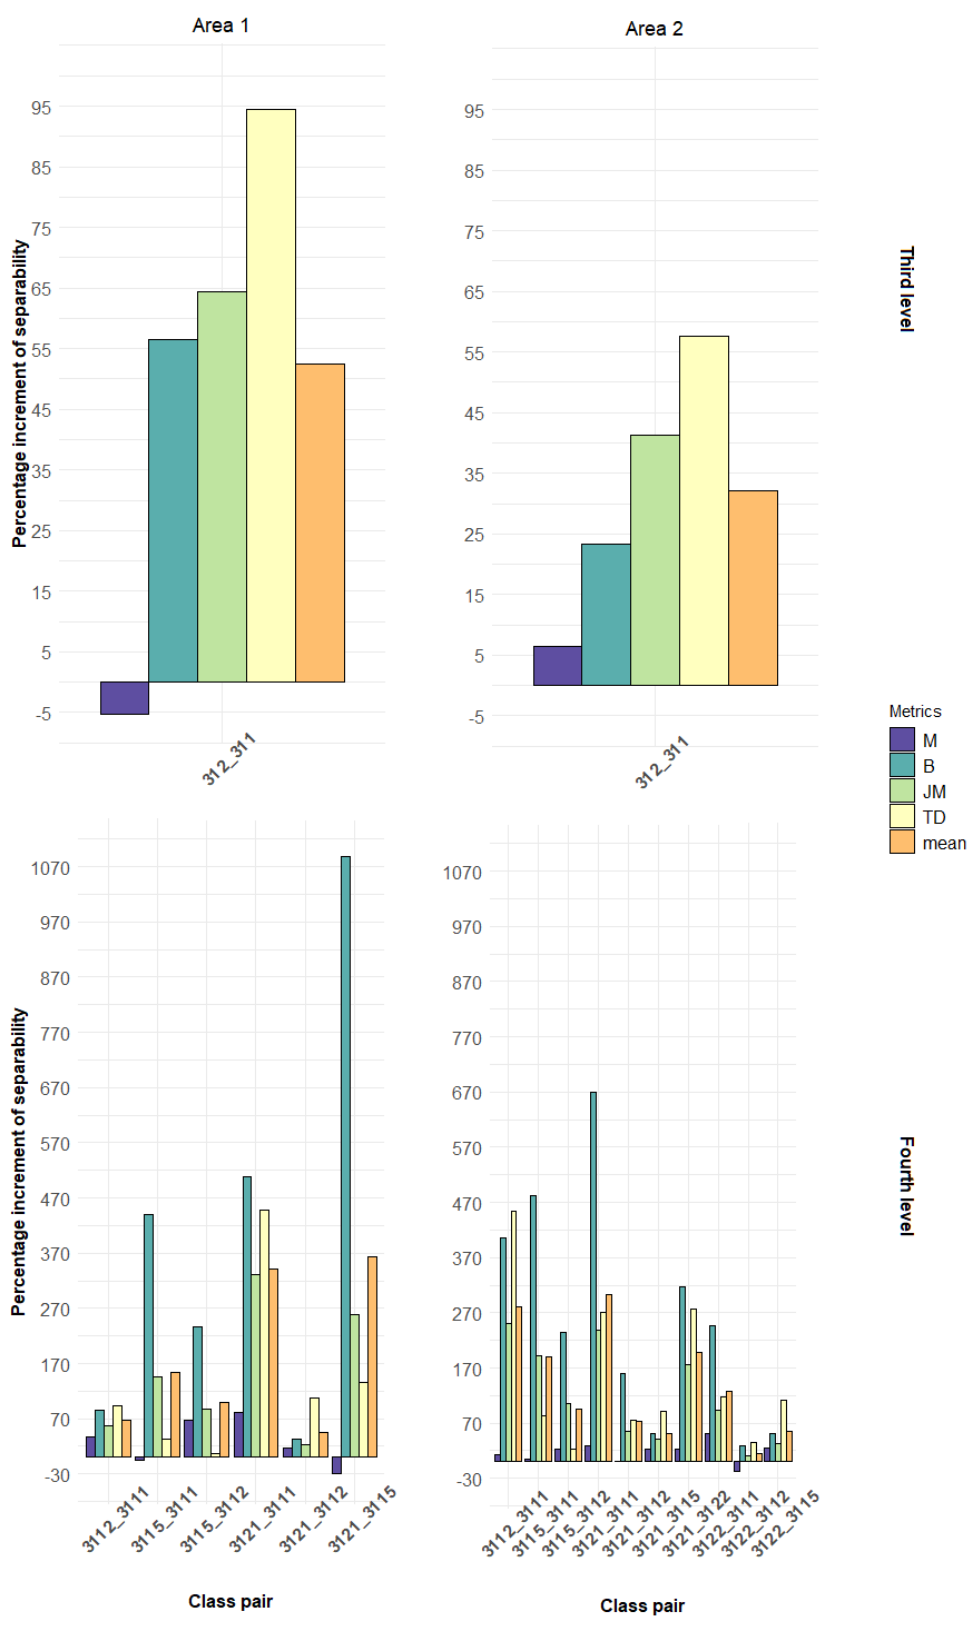
Figure 7. Percentage increment in PRISMA separability in respect to Sentinel-2. On top: the third level; on bottom: the fourth level.